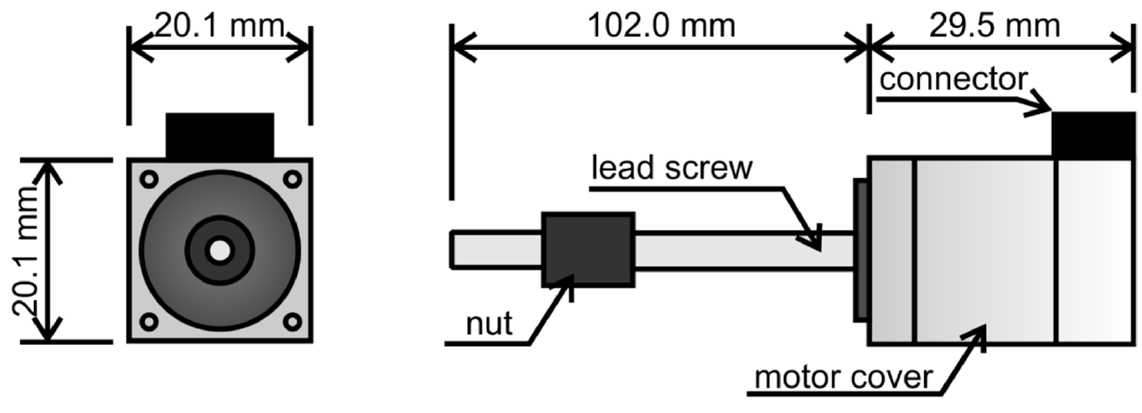
Figure 9. Dimensions of the MLS08A05-M04010S10160N-A000-XT1 stepper motor.